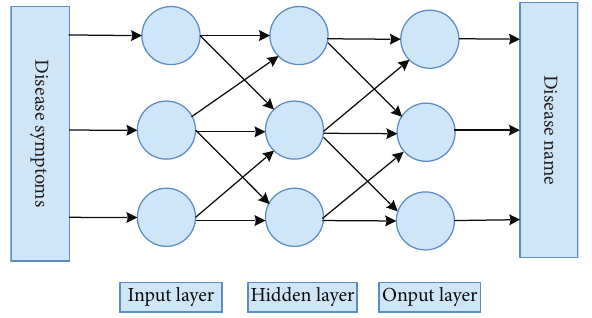
Figure 2: Connection rule flow